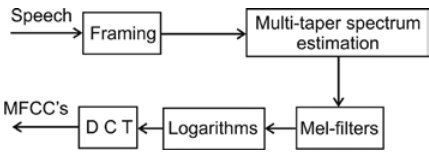
Figure 1: Block Diagram of the Multitaper MFCC